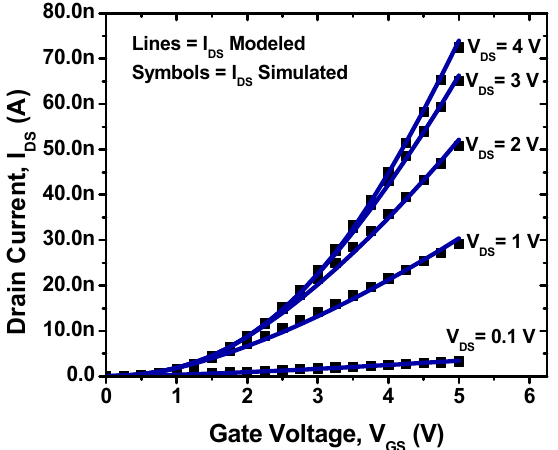
Figure 5. Comparison of modeled and simulated output characteristics I DS vs V GS at V DS = 0.1, 1, 2, 3, and 4 Volts.